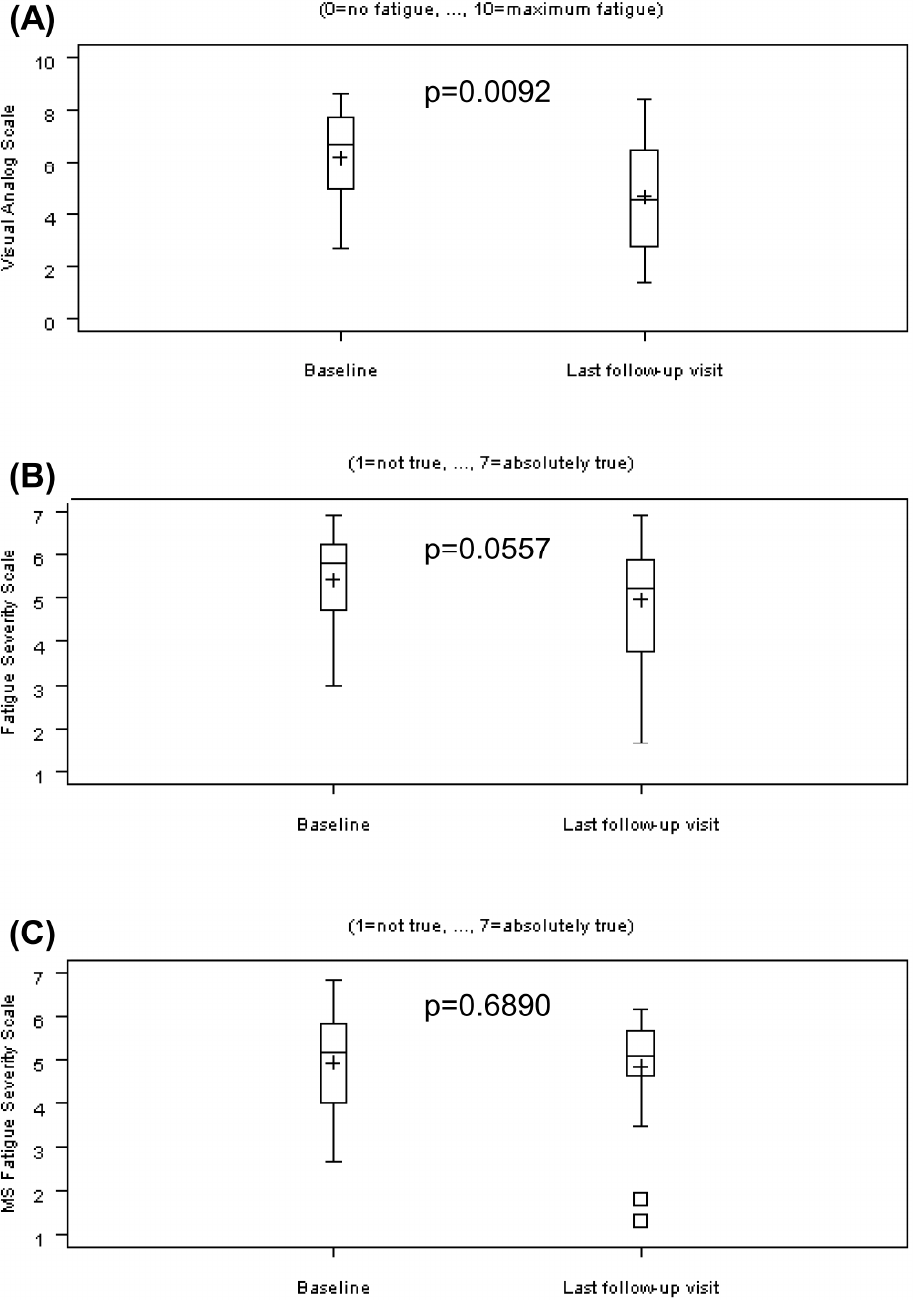
Figure 2. Fatigue self-assessment scales at baseline and last follow-up visit. ( A ) Visual Analog Scale (VAS), range from 0 (no fatigue) to 10 (maximum fatigue); ( B ) Fatigue Severity Scale (FSS), range from one (not true) to seven (absolutely true); ( C ) MS-Fatigue Severity Scale (MS-FSS), range from one (not true) to seven (absolutely true). Results are shown as mean (“+”), median (“—“), and standard errors.